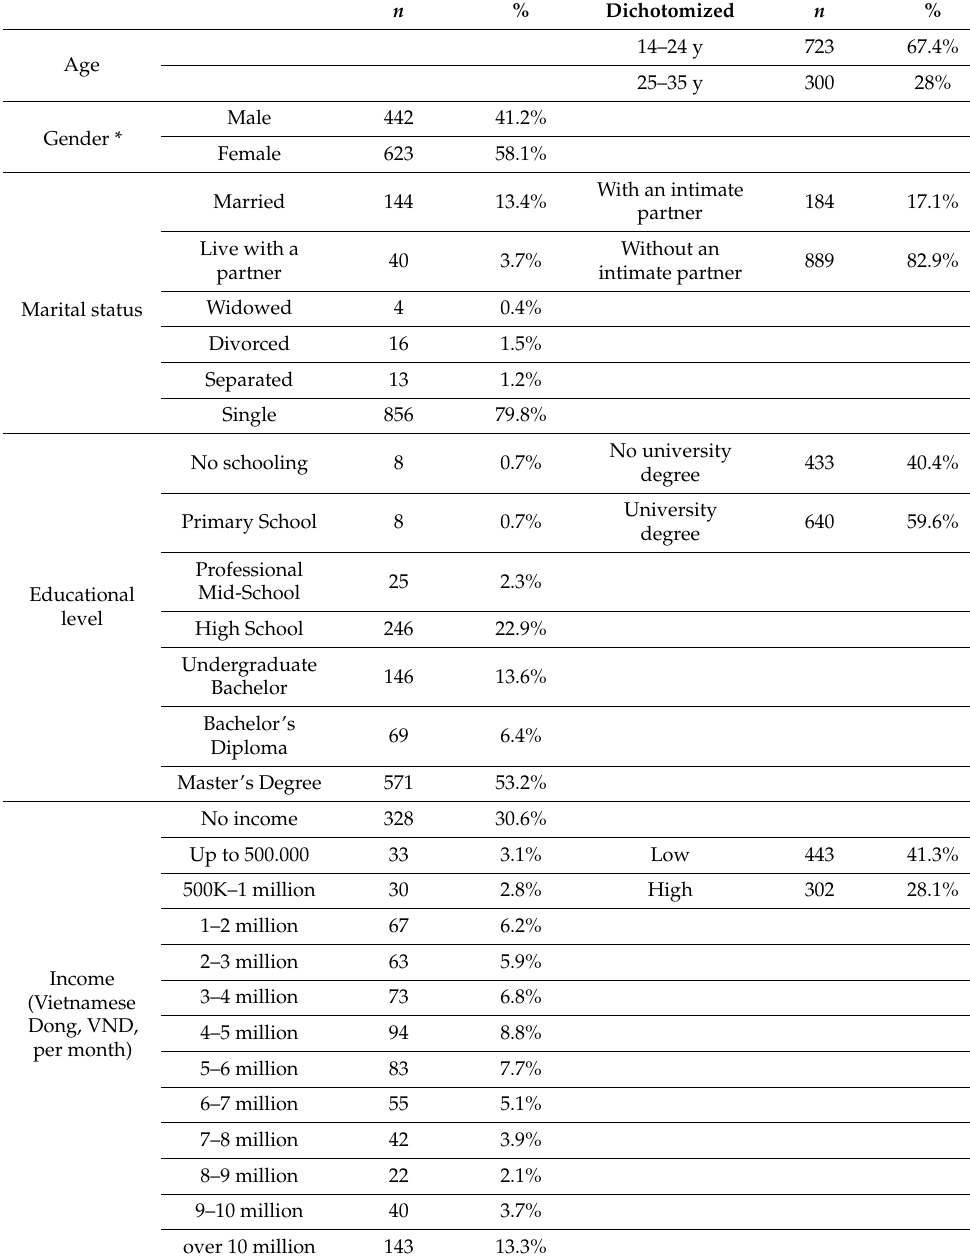
Table 1. Sociodemographic characteristics of the sample and of the dichotomized groups used to assess measurement